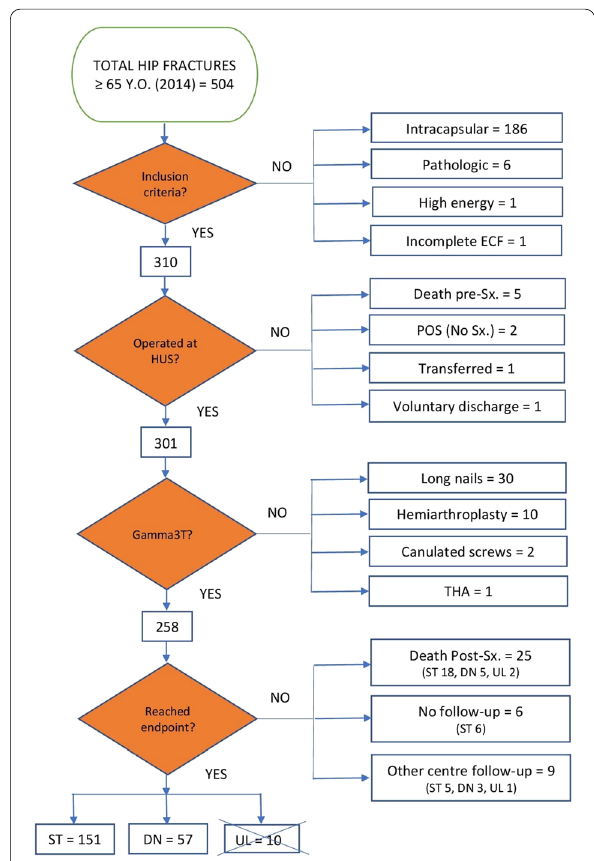
Fig. 1 Organisation chart. ECF, extracapsular fracture; HUS, Hospital Universitario de Salamanca; Sx., surgery; POS, poor overall status; THA, total hip arthroplasty; ST, static locking mode; DN, dynamic locking mode; UL, unlocked